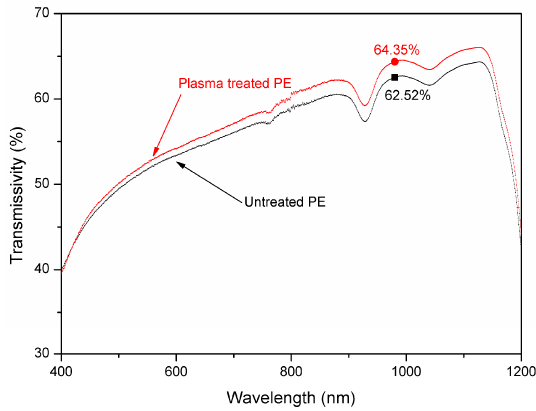
Figure 3. The transmissivity of PE before and after plasma treatment at different wavelengths.